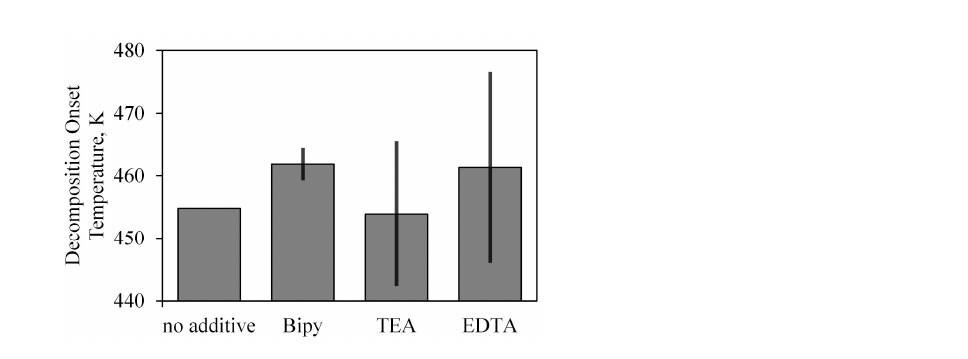
Figure 7. Bar graph comparing decomposition onset temperature averages and ranges for data above 10 K/min heating rate.